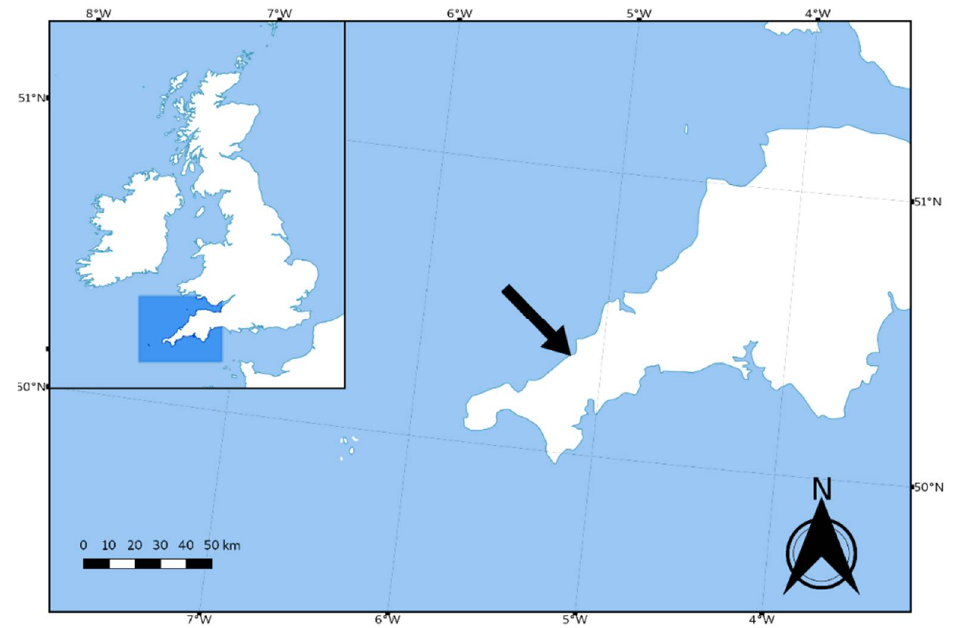
Figure 2. Map of study site (Perranporth beach location highlighted by black arrow).